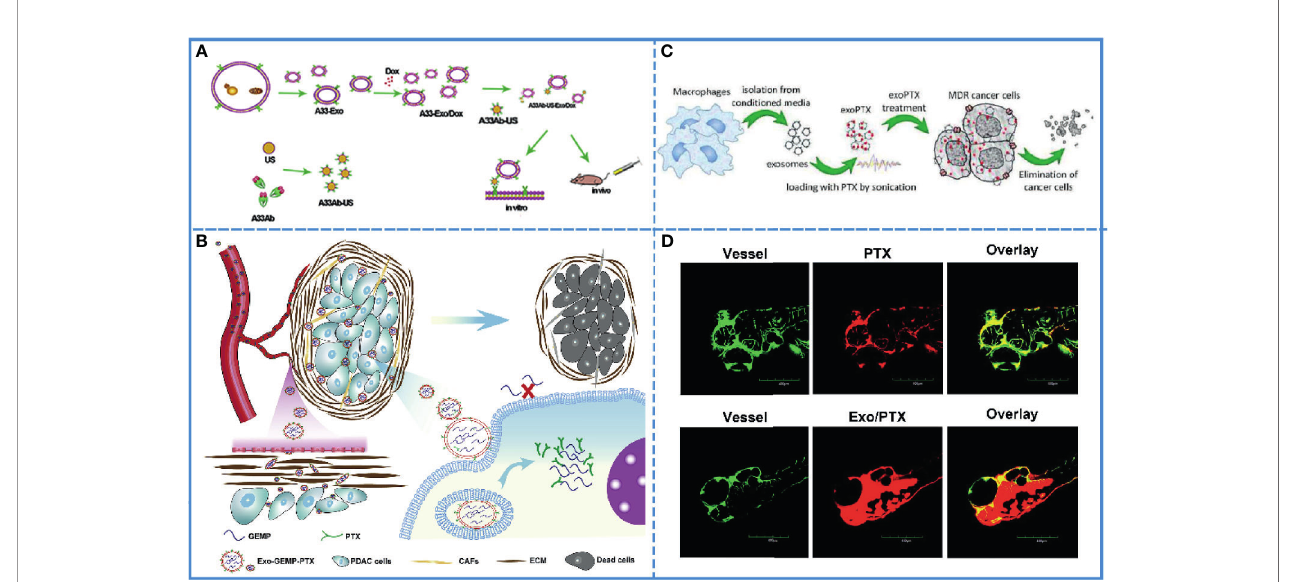
FIGURE 4 | Cancer chemotherapy. (A) Schematic illustration of A33Ab-US-Exo/Dox complex formation between A33 antibody-coated surface-carboxyl Fe 3 O 4 superparamagnetic nanoparticles (US) (A33Ab-US) and exosomes (A33-Exo) released from doxorubicin-loaded LIM1215 cells (A33-Exo/Dox). Reproduced with permission from ref (112). Copyright 2018 Elsevier. (B) Exosomes loaded with GEMP and PTX were used for targeted chemotherapy of pancreatic cancer via dual functions, i.e., stromal penetrability and anti-matrix and overcame chemoresistance. Reproduced with permission from ref (115). Copyright 2019 Elsevier. (C) Paclitaxel (PTX)-loaded exosomes (exoPTX), derived from autologous macrophages, exhibited high loading capacity, sustained drug release, profound ability to accumulate in resistant cancer cells, and elevated cytotoxicity compared to PTX. Reproduced with permission from ref (123). Copyright 2016 Elsevier. (D) Injection of fl uorescence-labeled PTX alone and those complexed with bEND3 exosomes in zebra fi sh embryos showed that Exo/PTX effectively crossed the BBB into the brain. Reproduced with permission from ref (124). Copyright 2015 Springer